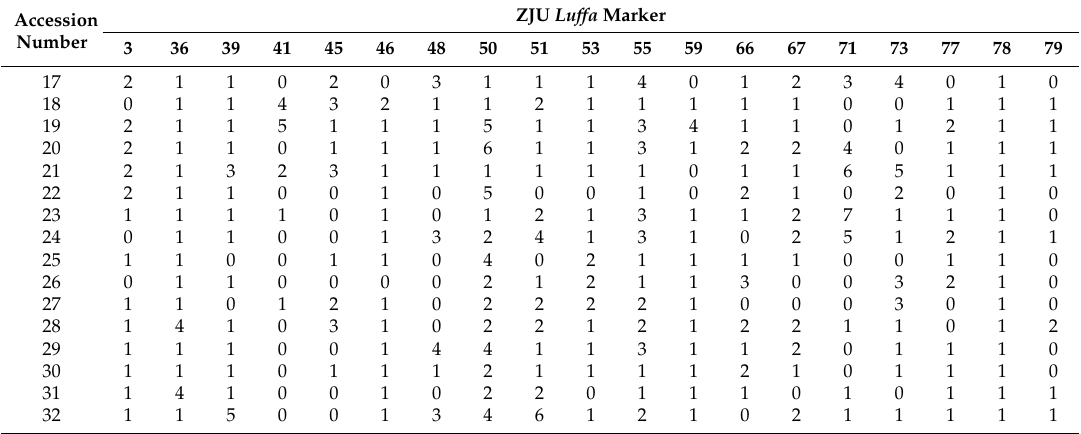
Figure 8. Evolutionary relationships of PCR products obtained with the SSR marker ZJULM 50 based on sequencing analysis. (Nos. 1–32, 32 accessions, detailed explanation can be seen in Table 7; the color of the branches is the same with the result of SSR-HRM group color in Figure 6E). According to these 19 group SSR-HRM genotype data (Table 5), dendrogram for 32 Luffa accessions were performed (Figure 9) based on Nei’s genetic distance coefficient [19], and then these 32 accessions were divided into two groups: Cluster A and Cluster B. Cluster A was comprised of 28 accessions belonging to L. cylindrica , and Cluster B included four accessions belonging to L. acutangula . The genetic distance coefficient between L. cylindrica and L. acutangula was 0.11, higher than 0.00 that was previously reported by Wu et al. [8]. According to cluster analysis above, the similarity among all these accessions ranged from 0.11 to 0.86.